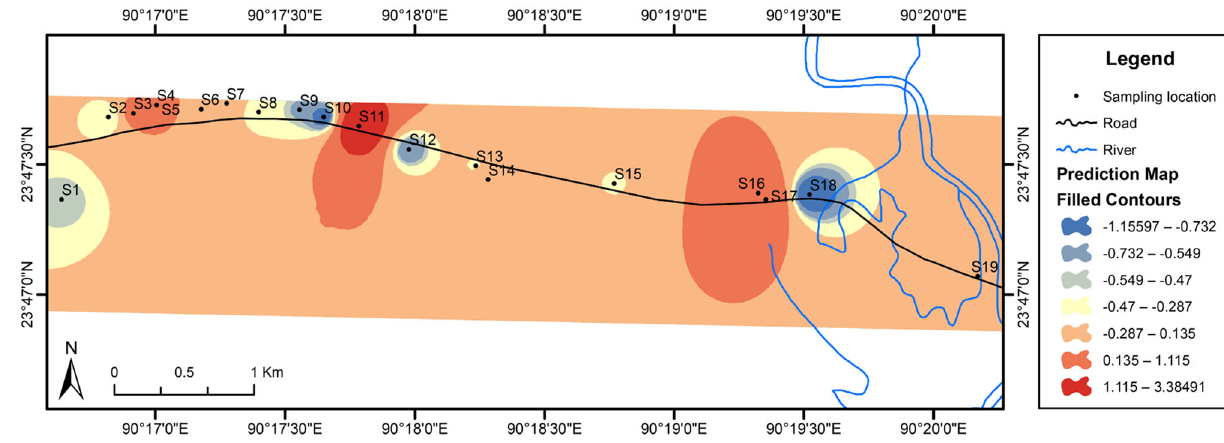
Fig. 6 Factor score map of principle component (PC3)